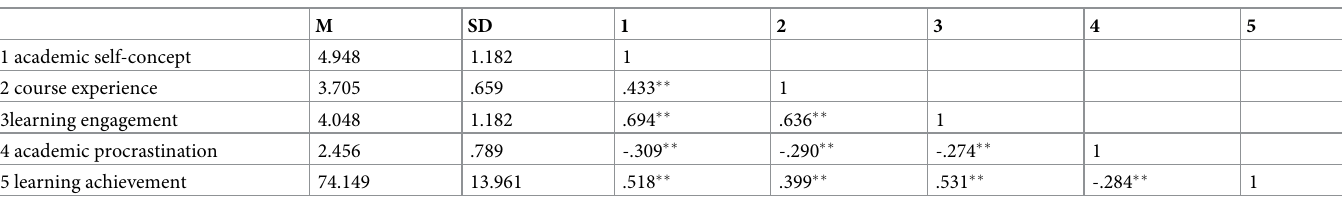
Table 1. Correlation analysis between descriptive statistical results and